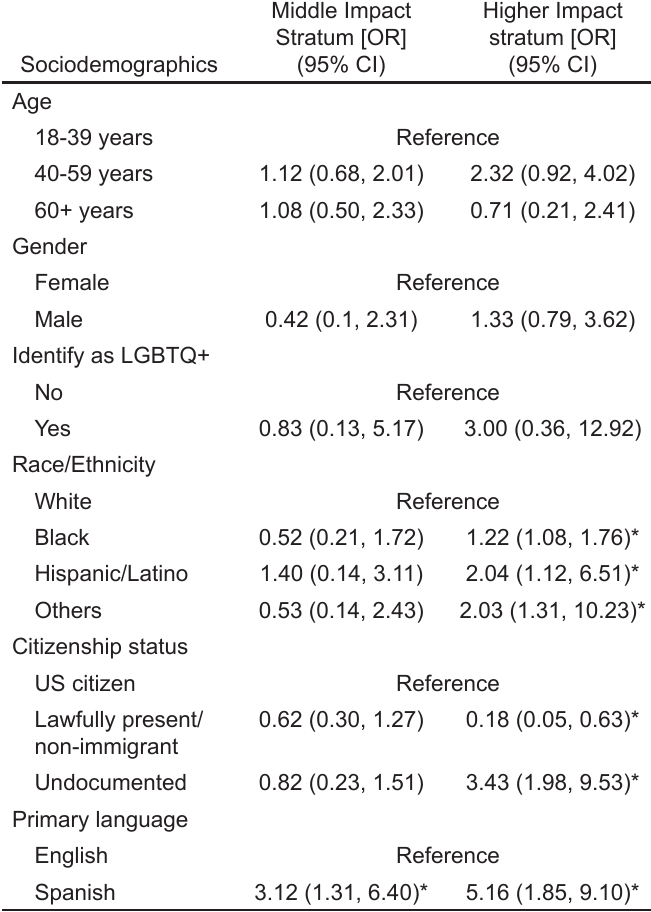
Table 3. Multinomial logistic regression between sociodemographic characteristics of patients visiting the emergency department and their social determinants of health stratum (lower impact stratum is the referent